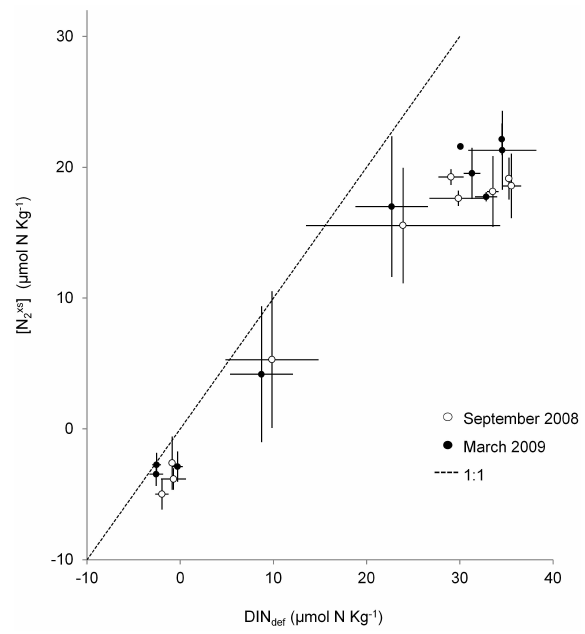
Fig. 9. Average DIN deficits (DIN def ) versus [N xs ) in the Cariaco Basin. The dashed line shows nus background N xs 2 the theoretical 1:1